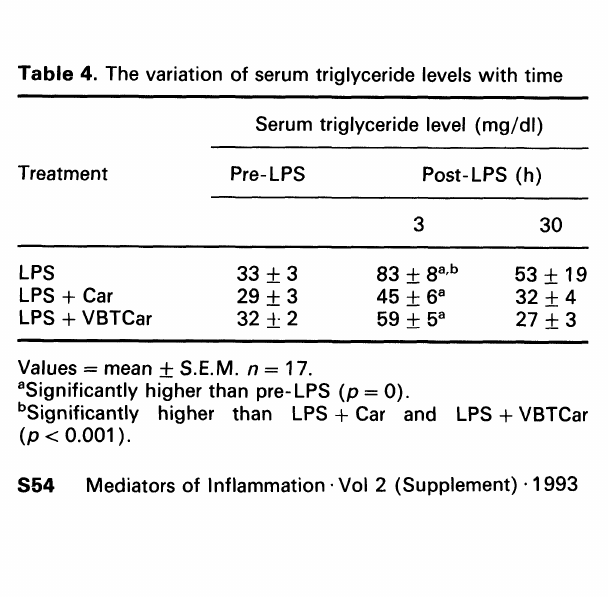
Table 4. The variation of serum triglyceride levels with time Serum triglyceride level (mg/dl)